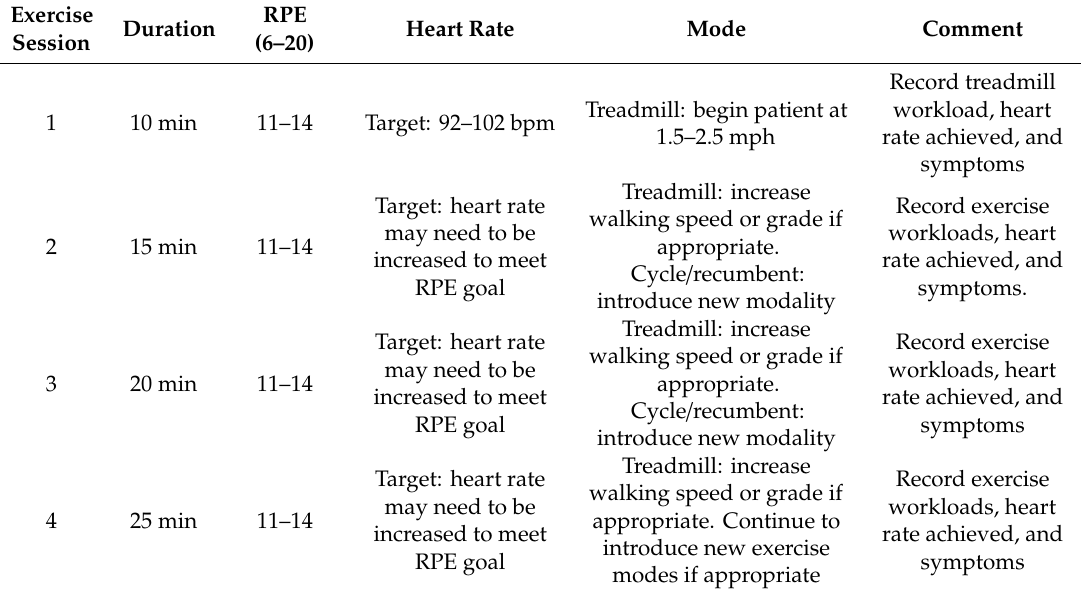
Table 1. Example of a progressive exercise program in cardiac